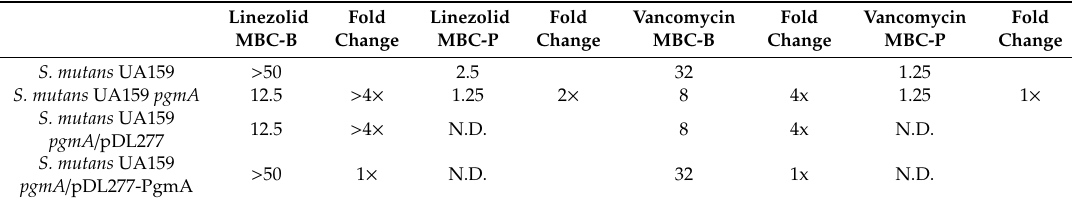
Table 3. Linezolid and vancomycin MBC-B and MBC-P ( µ g / mL) for the S. mutans wild type and derivatives. Fold change indicates the difference in antibiotic concentration compared to wild type. The data are from a representative experiment performed with three replicates. (N.D. means not determined).